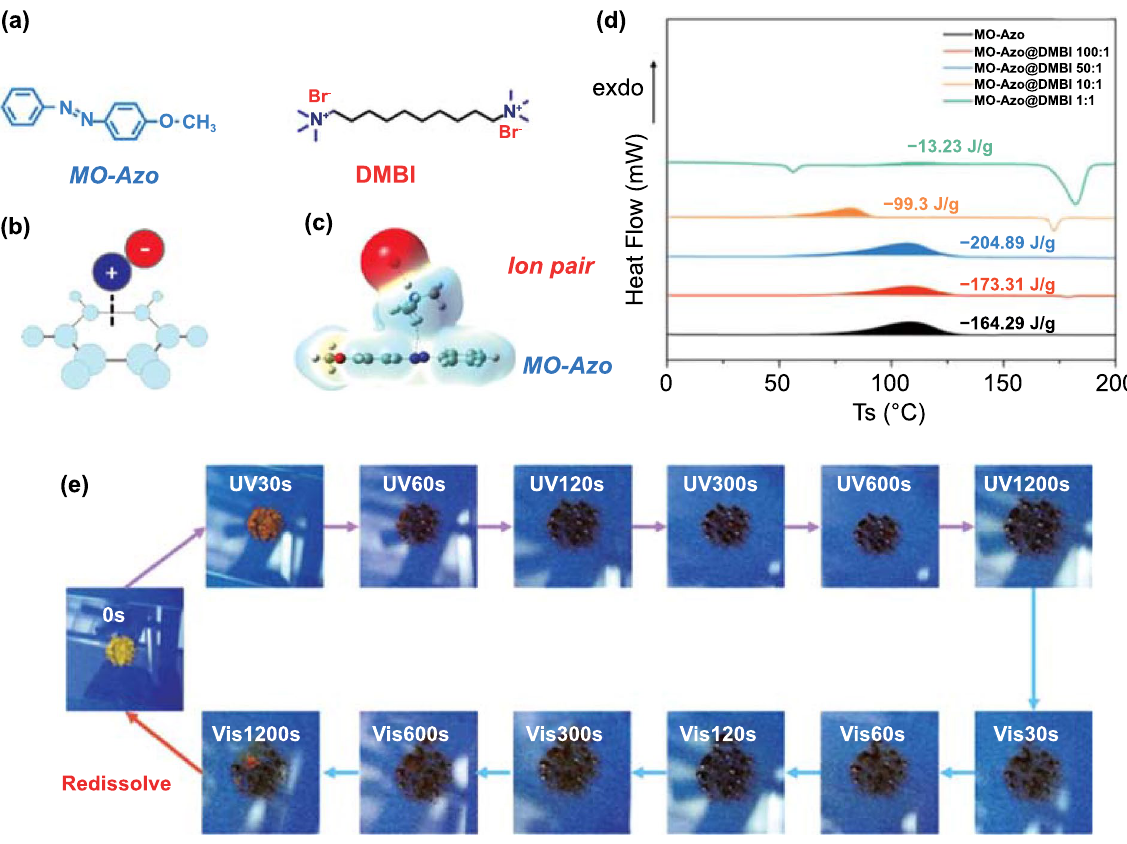
Fig. 5 a Materials used in the Cation– π interaction for enhancement of Azo-STF, b Scheme of “Cation– π ” interaction, c Simulation result of “Cation– π ” interaction d Energy storage/release property and stability of. DSC results of MO-Azo@DMBI X:1 with different DMBI content (“MO-Azo” corresponds to 4-methoxyazobenzene, “DMBI” is the abbreviation for decanoquaternary amine bromide, and “X:1” is the mole ratio of these two compounds, respectively); e Real-time photographs of MO-Azo@DMBI 50:1 during one “charging–discharging” cycle